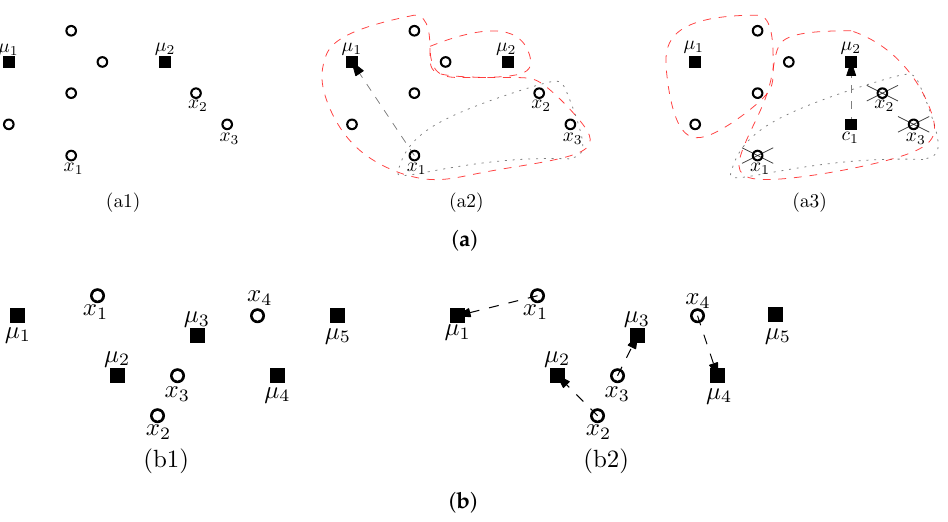
Figure 1. Examples of processing must-links and cannot-links. ( a ) Must-link examples. (a1) is the original graph with the must-link set { x 1 , x 2 , x 3 } and the mass clusters µ 1 and µ 2 . (a2) is a possibly solution produced by [20] while (a3) is the solution of our algorithm. ( b ) A cannot-link example. (b1) A cannot-link set { x 1 , x 2 , x 3 , x 4 } with four clustering centers { µ 1 , µ 2 , µ 3 , µ 4 , µ 5 } ; (b2) an assignment of the points in the cannot-link set to the